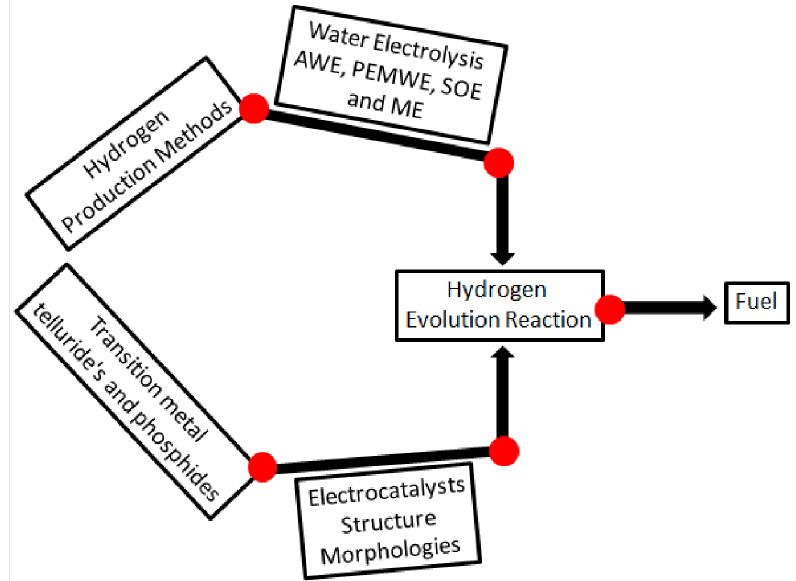
Figure 2. Schematic illustration of the article’s